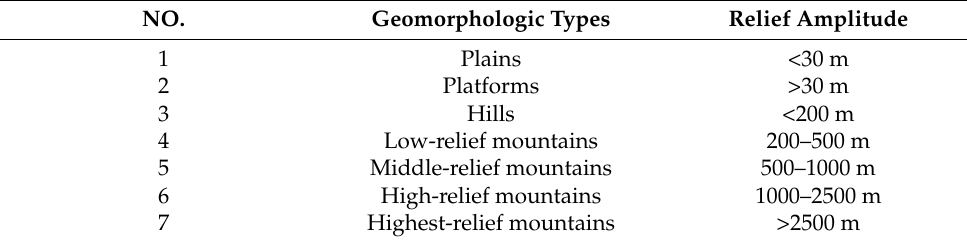
Table 1. Classification system of the basic geomorphologic types of Chinese territory [60].